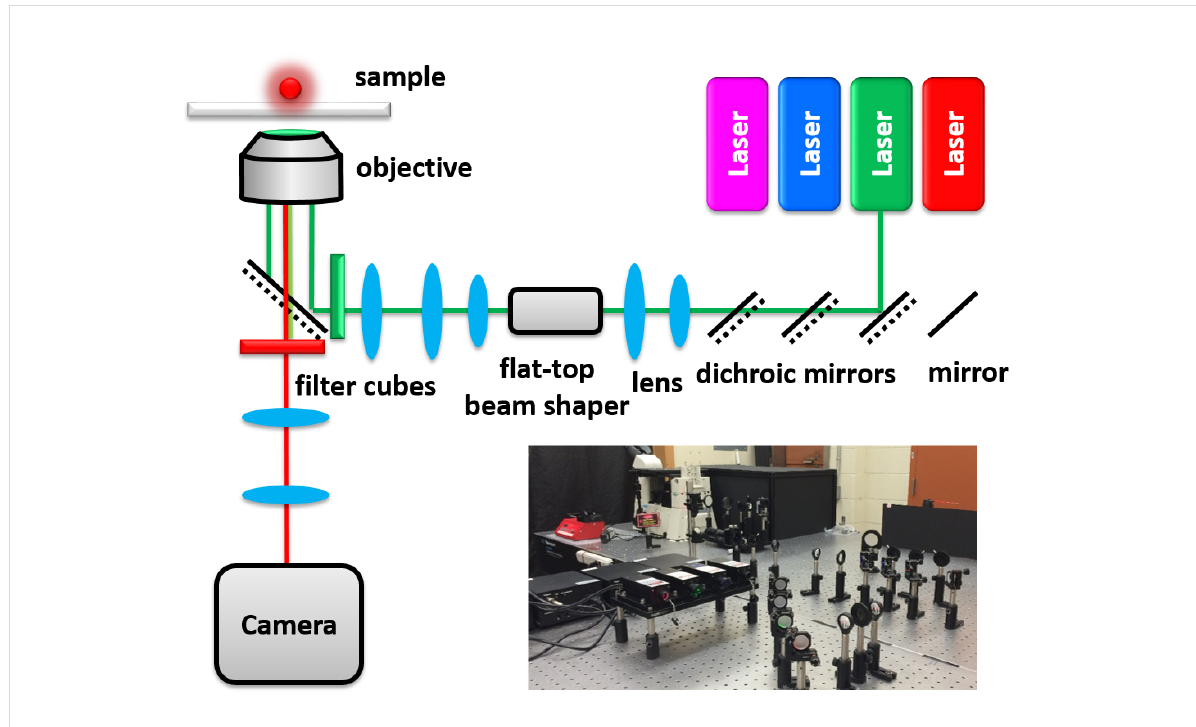
Figure 2: Scheme and image of the optical